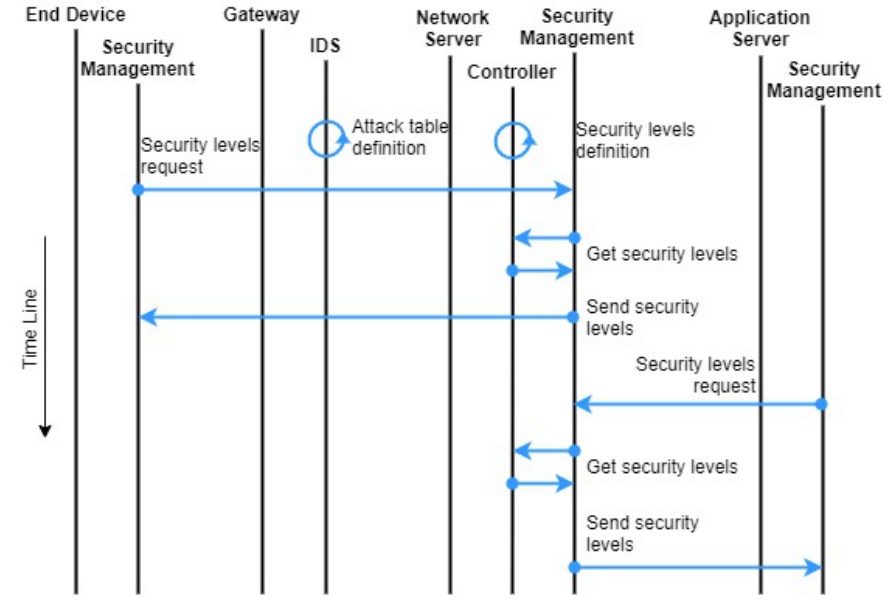
Figure 3. Setup phase of the proposed architecture (protocol